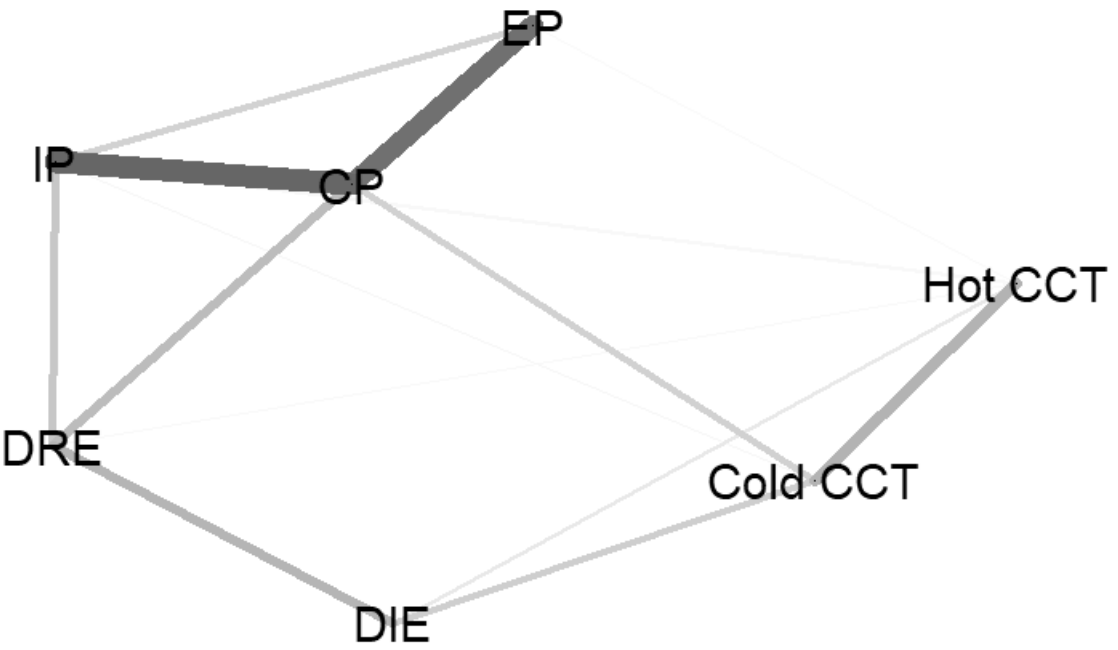
Figure 5. A network containing Externalizing Problems (EP), Internalizing Problems (IP), Cognitive Problems (CP), Difficulties in Regulating Emotions (DRE), Difficulties in Identifying Emotions (DIE), and risk propensity in the Hot and Cold CCT. The edge thickness represents the strength of an association. Legend: IP = Internalizing Problems; EP = Externalizing Problems; MCP = Mixed Cognitive Problems; DRE = Difficulties in Regulating Emotions; DIE = Difficulties in Identifying Emotions.